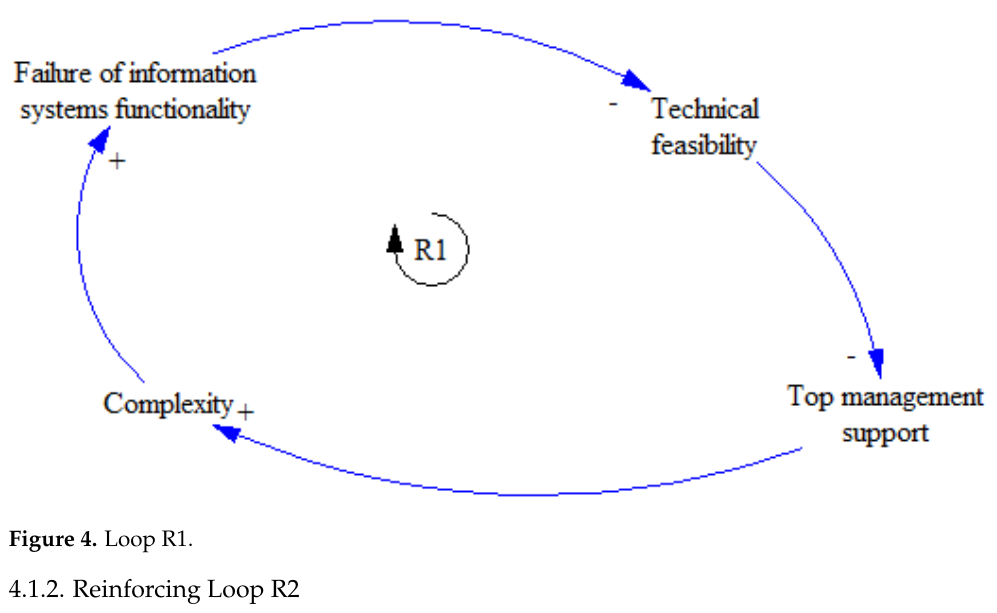
Figure 4. Loop R1.